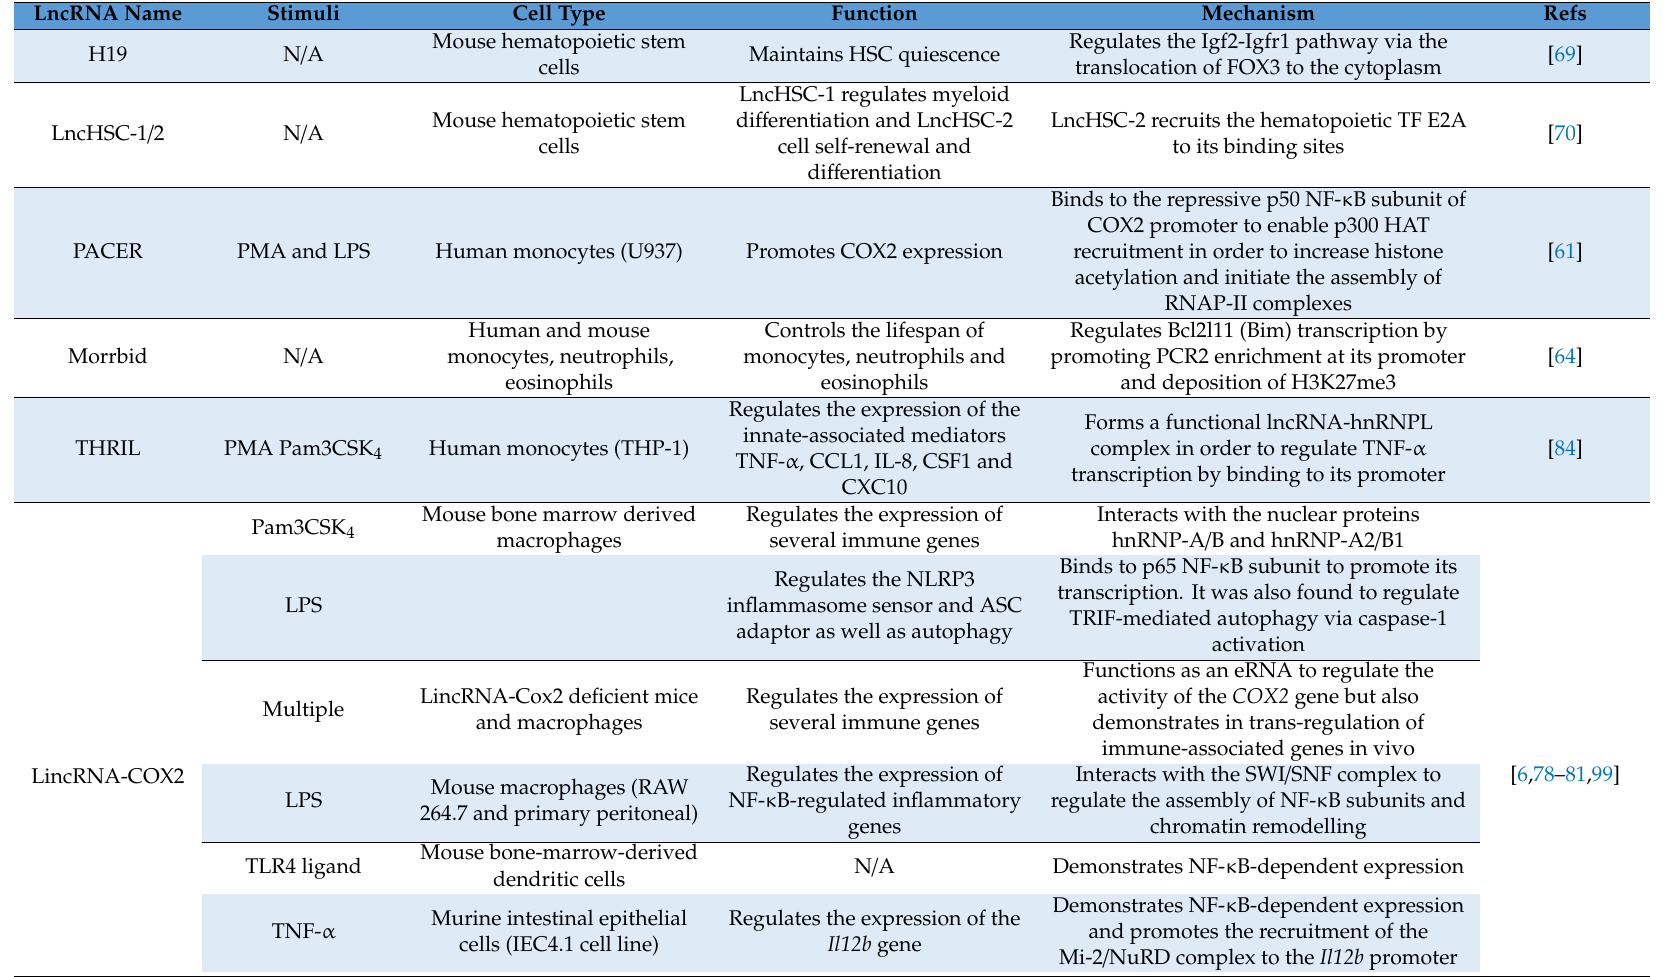
Table 1. LncRNAs associated with the innate immune